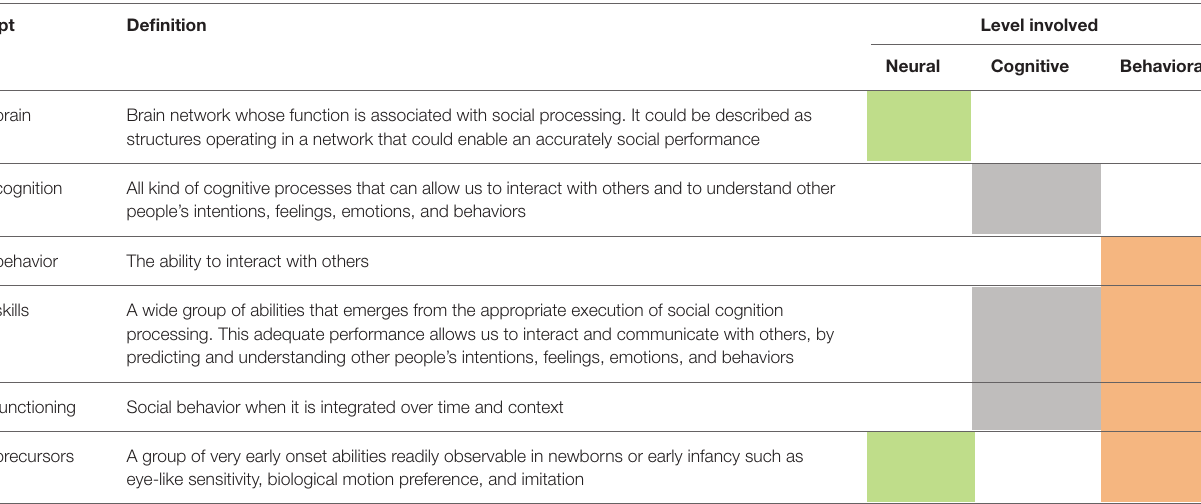
TABLE 1 | Social concepts.